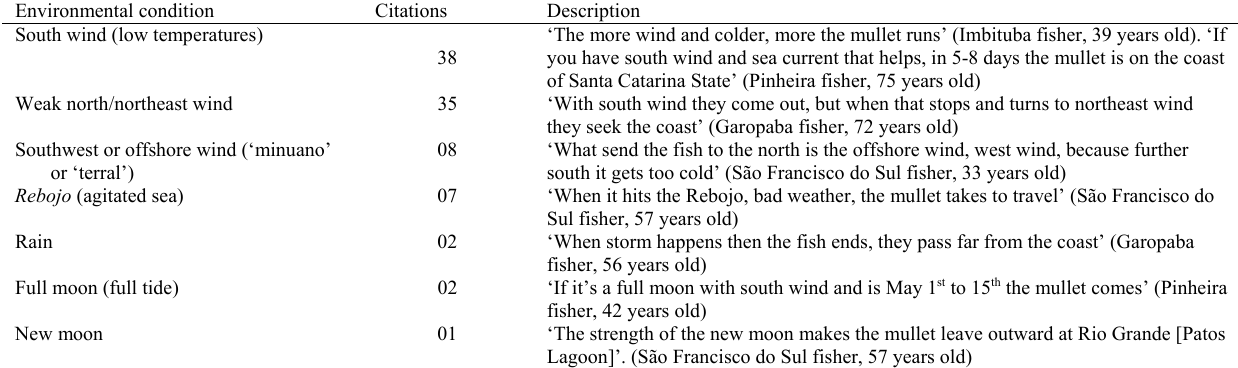
Table 2. Environmental conditions affecting mullet migration, according to 45 interviewed fishers in Santa Catarina State,